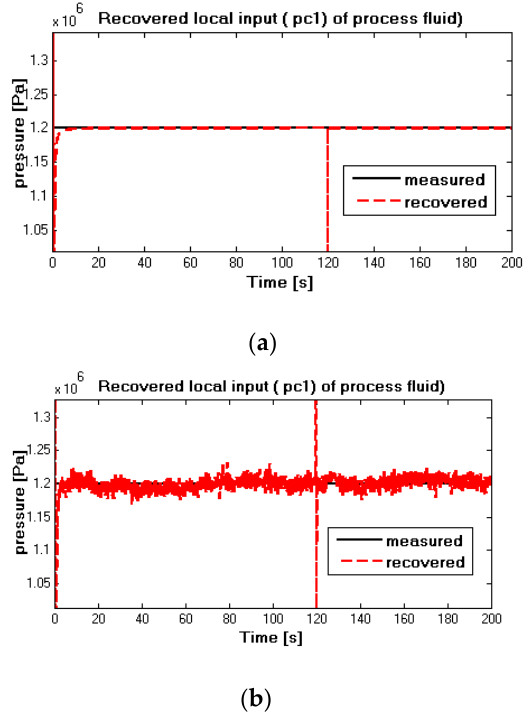
Figure 14. ( a ) Measured and recovered (cid:1868) (cid:3030)(cid:2869) ( noise-free situation) in case 2; ( b ) measured and recovered (cid:1868) (cid:3030)(cid:2869) ( noise-corrupted situation) in case 2. The simulation results of pneumatic pressured (cid:1868) (cid:3030)(cid:2870) of utility fluid case are plotted in Figure 15a,b. Similar to the situation of (cid:1868) (cid:3030)(cid:2869) of the process fluid, under the noise-free case